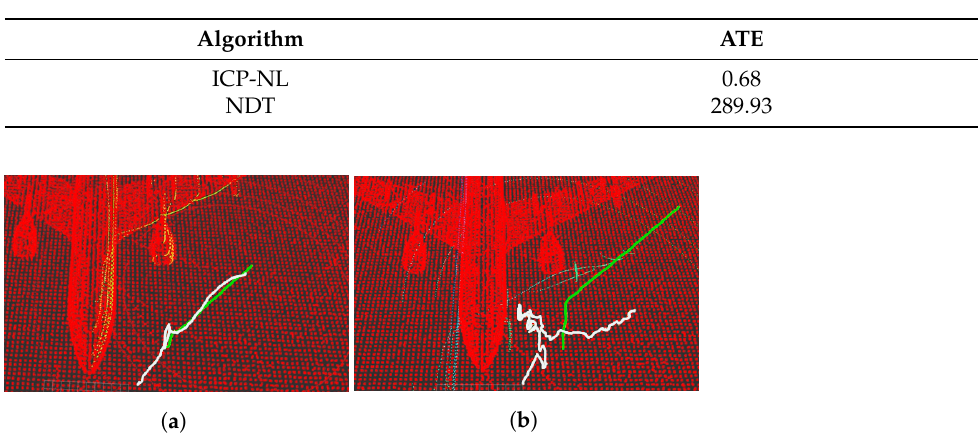
Figure 24. Position estimate by the algorithms Non-linear ICP ( a ) and NDT ( b ). Three-dimensional graph SLAM map (red), position estimate by the algorithm (white), ground truth (green).